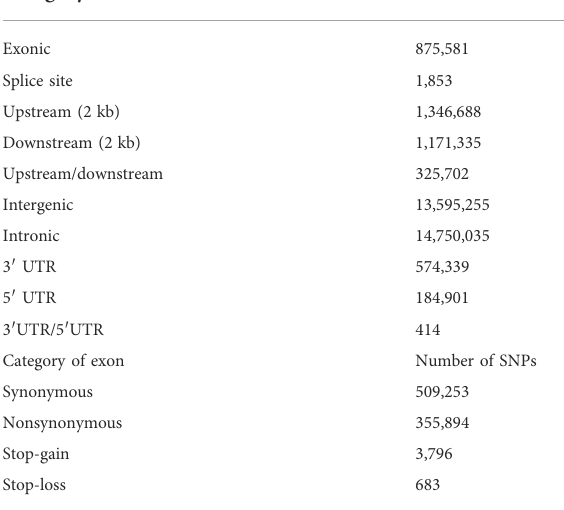
TABLE 1 Statistics for SNP annotation